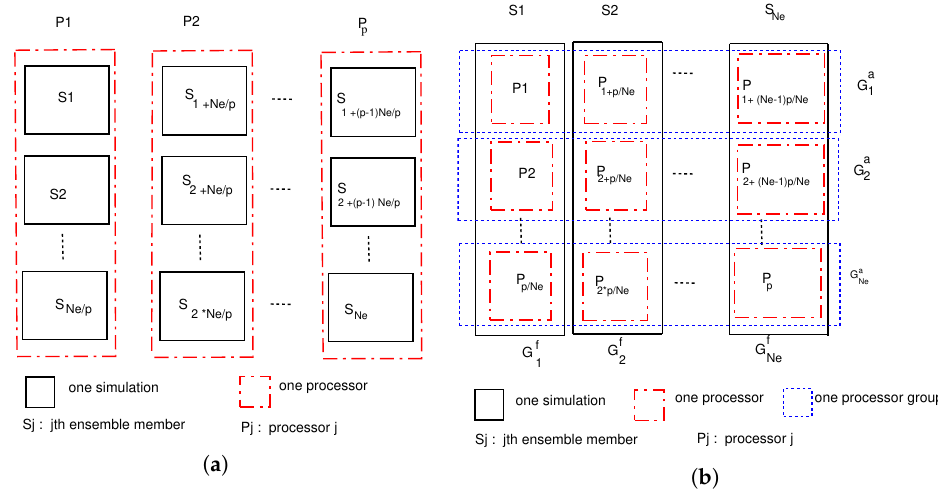
Figure 2. The allocation of the ensemble members and the simulations in different processors: ( a ) N e > p and ( b ) N e < = p